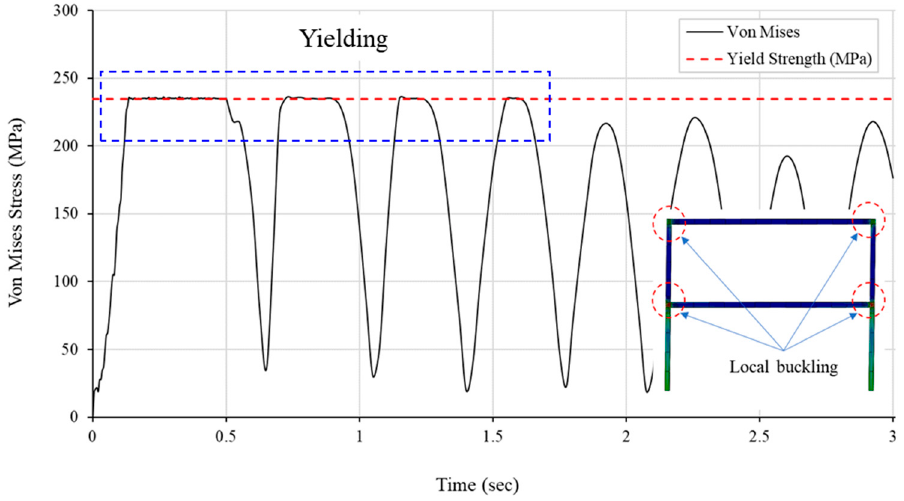
Figure 18. Yielding and buckling in the validated model.